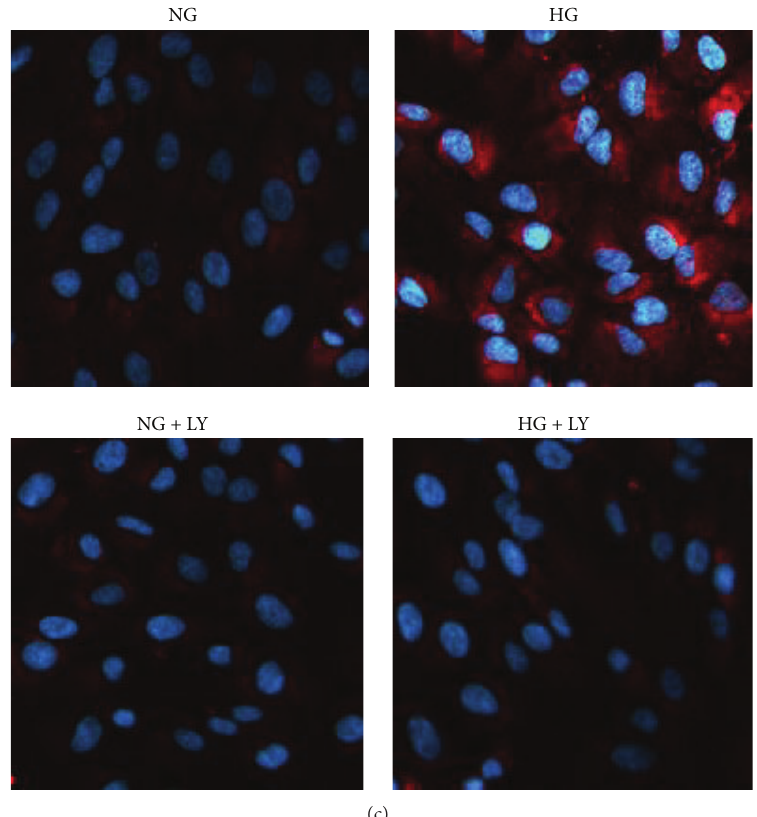
Figure 7: Immunofluorescence staining of fibronectin, collagen IV, and laminin in RPE cells. The expression of fibronectin, collagen IV, and laminin was evaluated by pretreatment with 20 𝜇 M LY294002 for 12 h and then incubation with 24h in RPE cells under high glucose conditions. The RPE cells showed more intense staining under high glucose conditions compared with NG or HG + LY. (a) Fibronectin; (b) collagen IV; (c) laminin. DAPI: